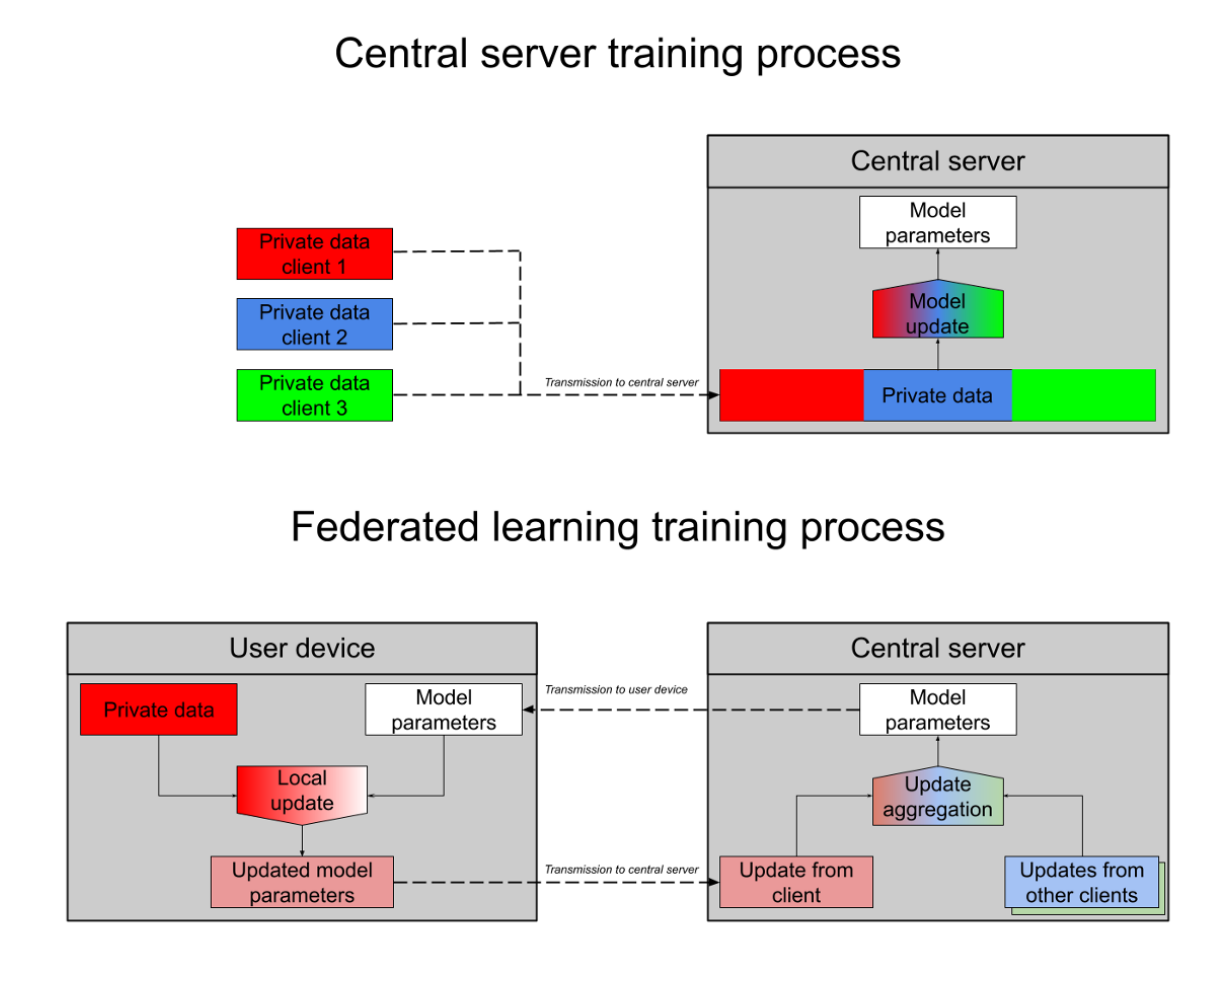
Figure 1. Diagram comparing central and federated learning workflows. Color abstractly represents the private information content at different locations, with red, blue, and green colors representing private information for different user devices. When training on a central server, user data are uploaded onto the server once. In federated learning, model parameters are updated on the user device, producing updates that contain less private information than the data themselves. The updates from many users are then aggregated, further mixing the contribution from each individual user.